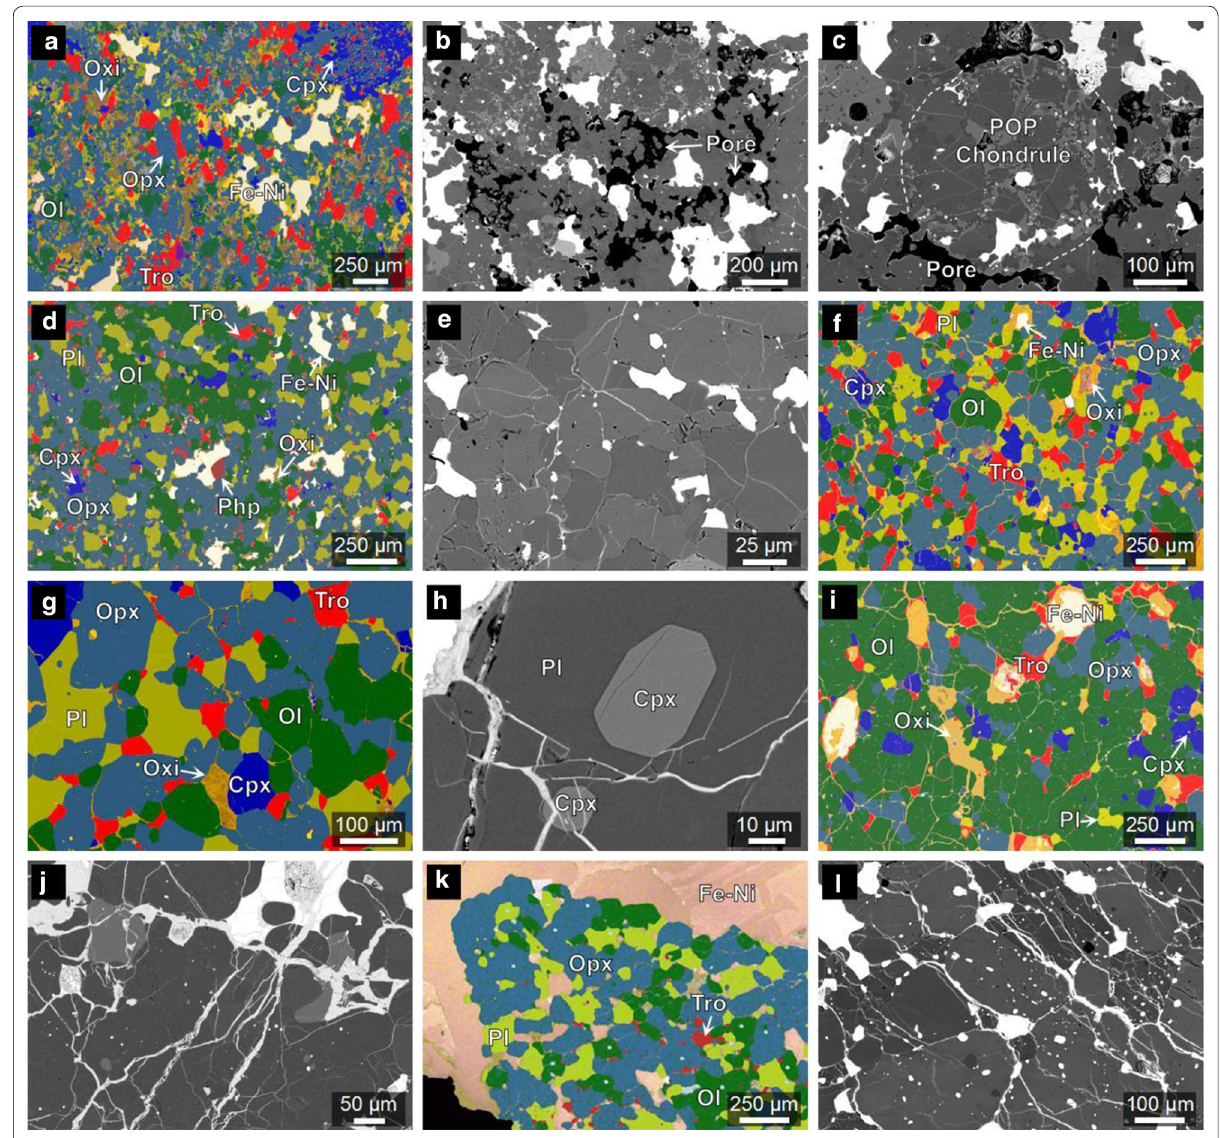
Fig. 2 Petrologic textures of the studied winonaites. a – c Representative areas of NWA 725 with relict chondrules (e.g., Figure 2c). d , e The representative areas of NWA 6448 with fine-grained texture. f , g Representative area of GRV 022890 with medium-grained equigranular texture. h Two euhedral clinopyroxene crystals are enclosed by plagioclase in GRV 022890. i , j Representative areas of GRV 021663 with coarse-grained olivine-rich texture and metal veinlets. k Representative area of NWA 4024 with the coarse-grained metal-rich texture. l Curvilinear trails of metallic FeNi blebs (white) in mafic silicate grains of NWA 4024. The labeled minerals include olivine (Ol), orthopyroxene (Opx), clinopyroxene (Cpx), plagioclase (Pl), FeNi metal (Fe–Ni), troilite (Tro), and Fe-oxides (Oxi). POP porphyritic olivine–pyroxene